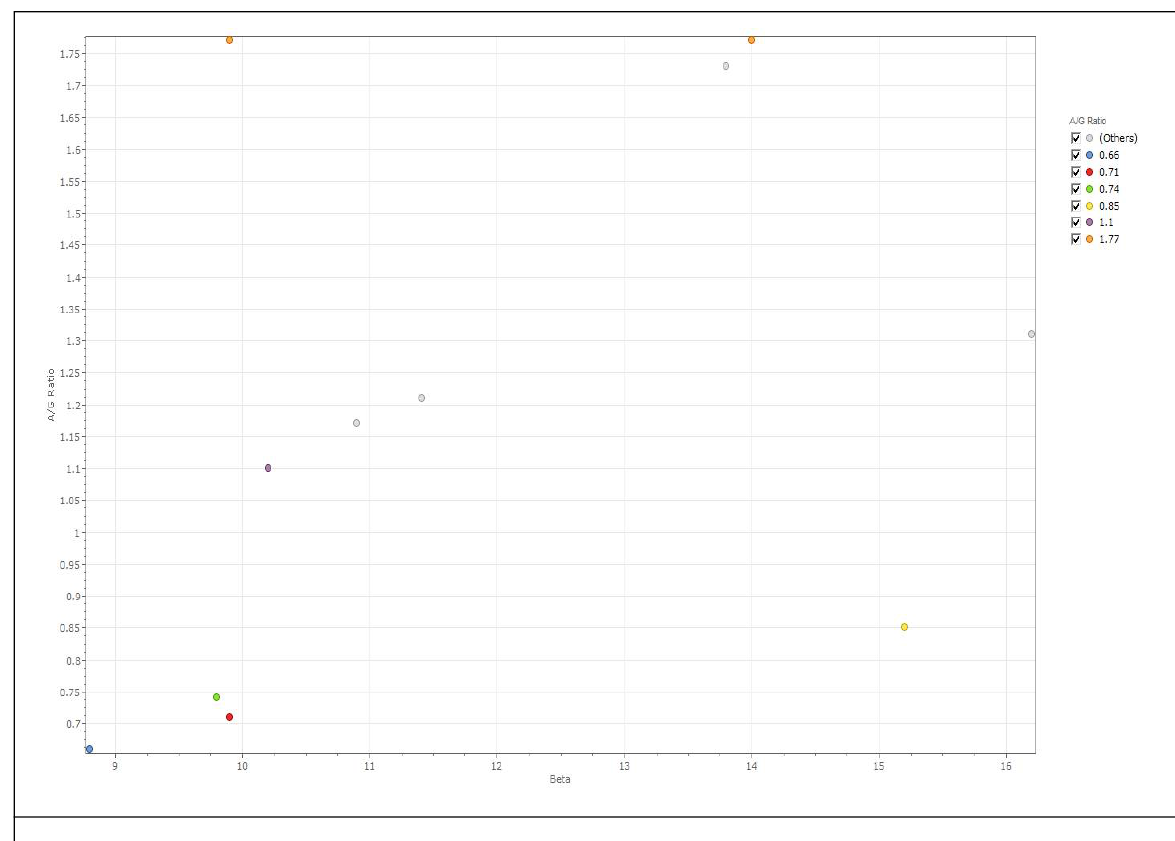
Figure 8: Scatter plot of A/G ratio with respect to beta